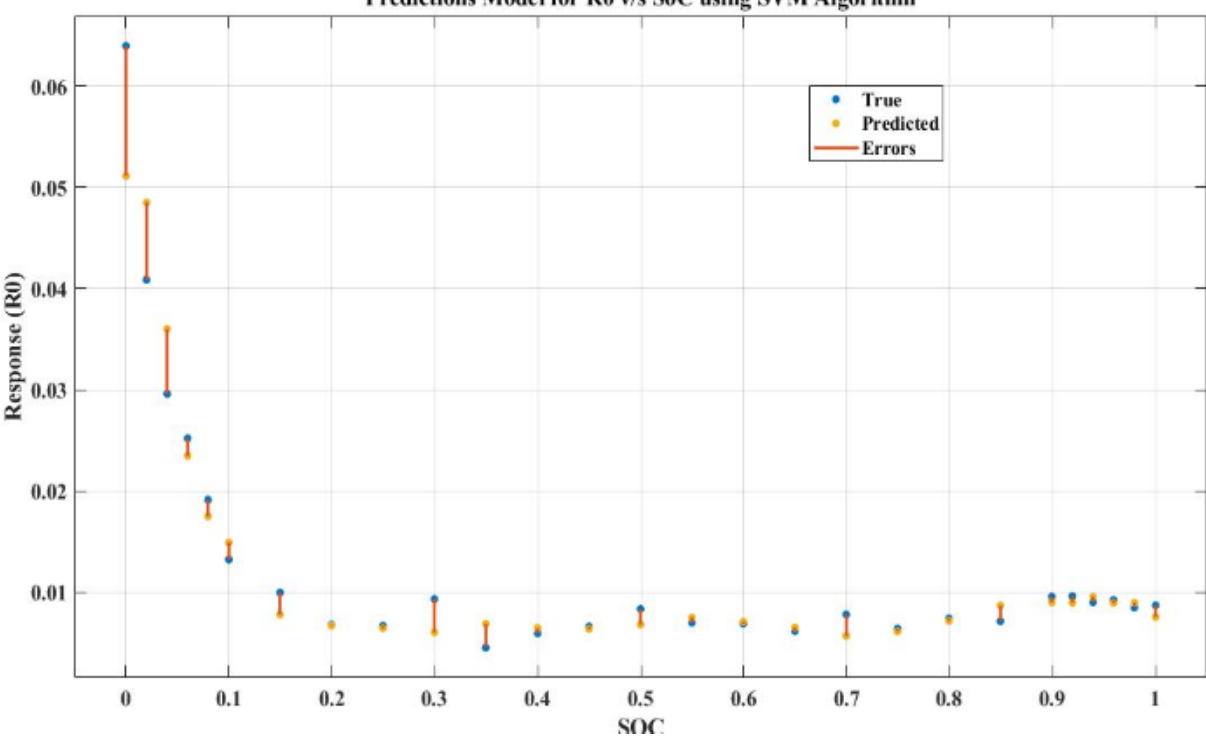
Figure 21. Prediction model for parameter estimation: R 0 vs. SOC.